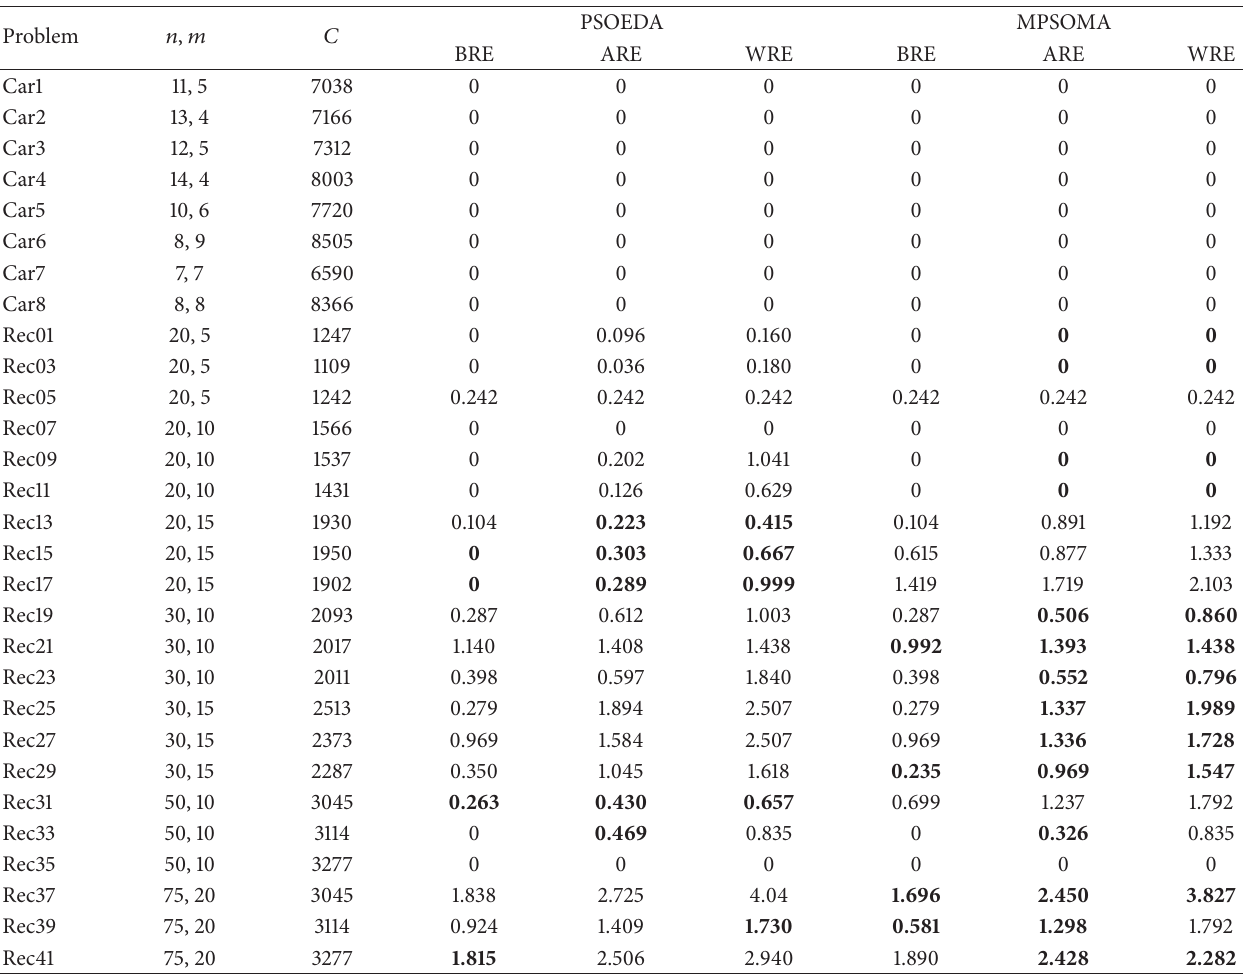
Table 3: Comparisons of PSOEDA and